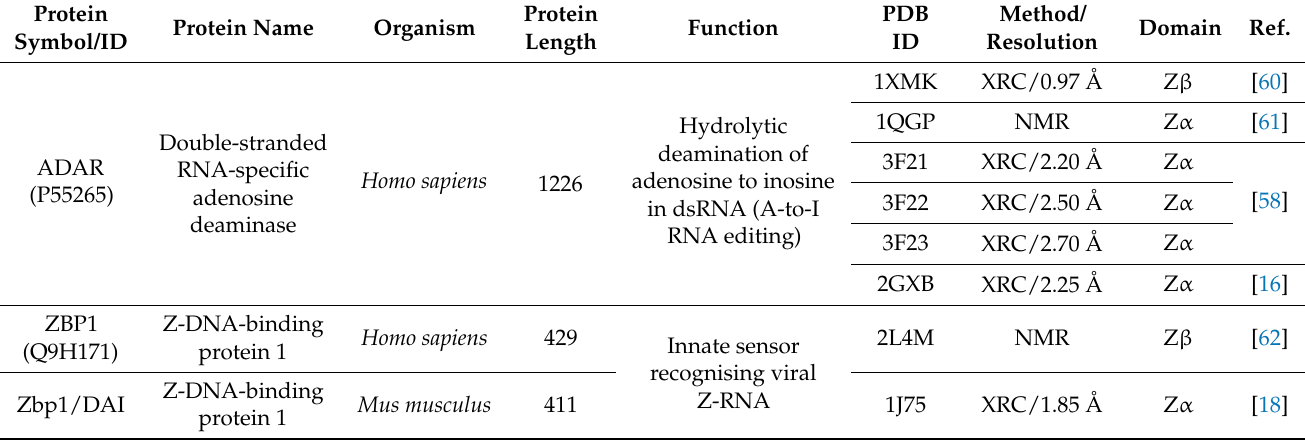
Table 1. Known Z-DNA/RNA binding proteins containing experimentally solved Z α or Z β